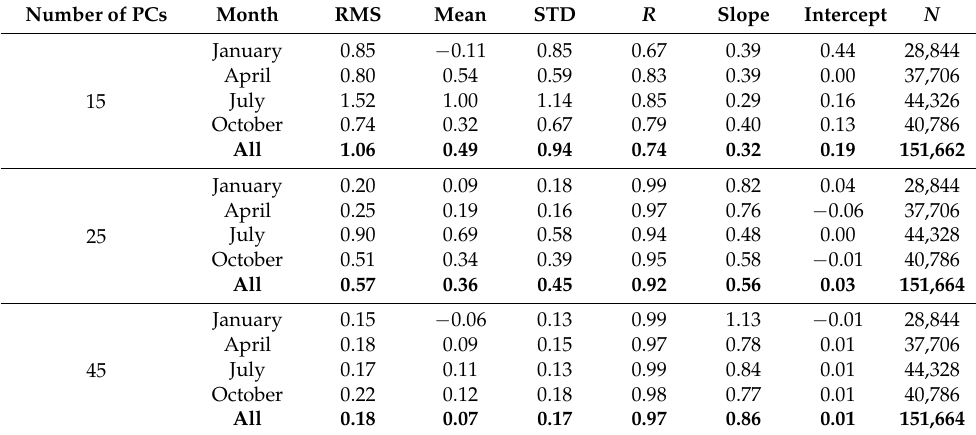
Table 3. Various statistical parameters describing the difference between retrieved SiF values for the months of January, April, July and October 2013 when using 15, 25 or 45 PCs as compared to 35 PCs (baseline). Only grid boxes over land are taken into account. Parameters are the root-mean-square difference (RMS), the mean difference and the standard deviation (STD) of the difference, the correlation coefficient ( R ), the slope and intercept of the regression line, and finally the total number of valid monthly grid box pairs ( N ) from which differences are calculated. The difference is defined as SiF(test) − SiF(baseline) and the regression line as SiF(baseline) = intercept + slope × SiF(test). All correlations are highly significant. The unit of SiF values is mW/sr/m 2 /nm, as before. Number of PCs Month RMS Mean STD R